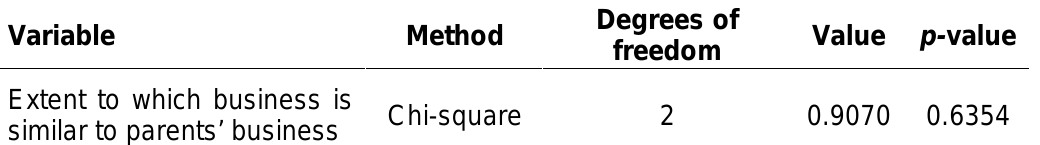
Table 11: Significant Differences Relating to Family Tradition of